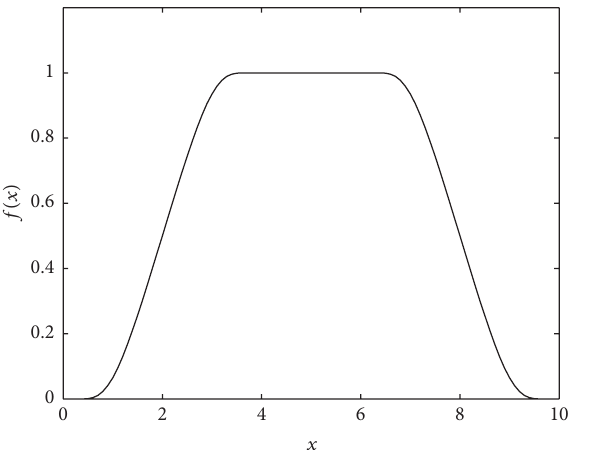
Figure 1: Function 𝑓(𝑥) with Δ𝑥 rise = Δ𝑥 fall = 3 .